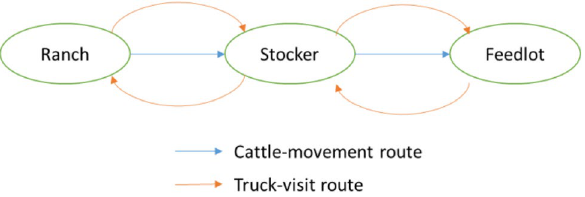
Figure 1. Transmission routes of the FMD virus among different production types of beef-cattle